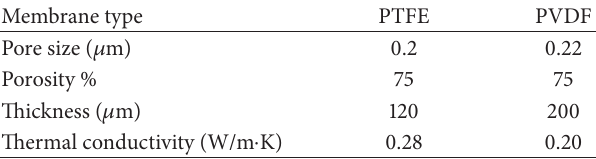
Table 1: Membrane